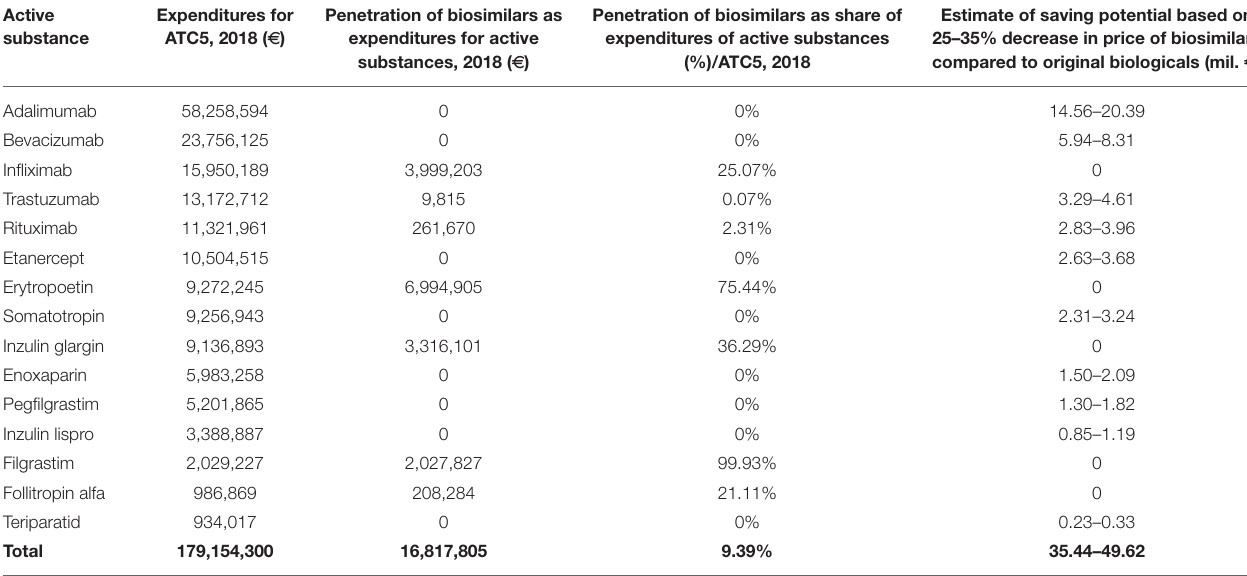
TABLE 2 | Estimate of financial savings from biosimilars, based on data from the State Institute for Drug Control. Active substance